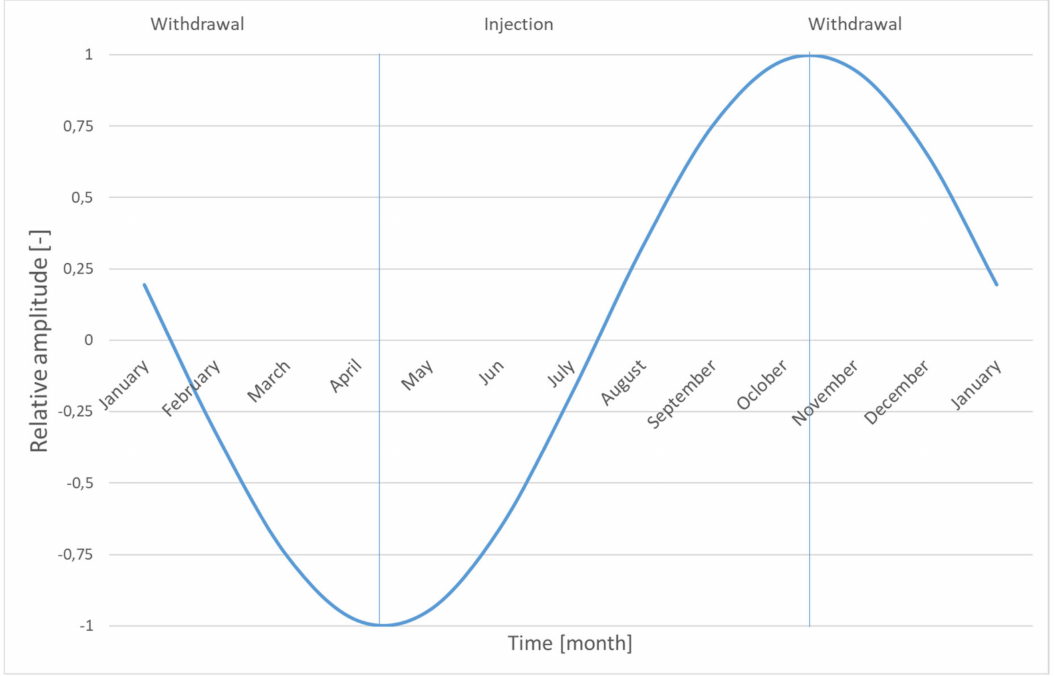
Figure 1. The theoretical course of injection and withdrawal cycle at an underground gas storage